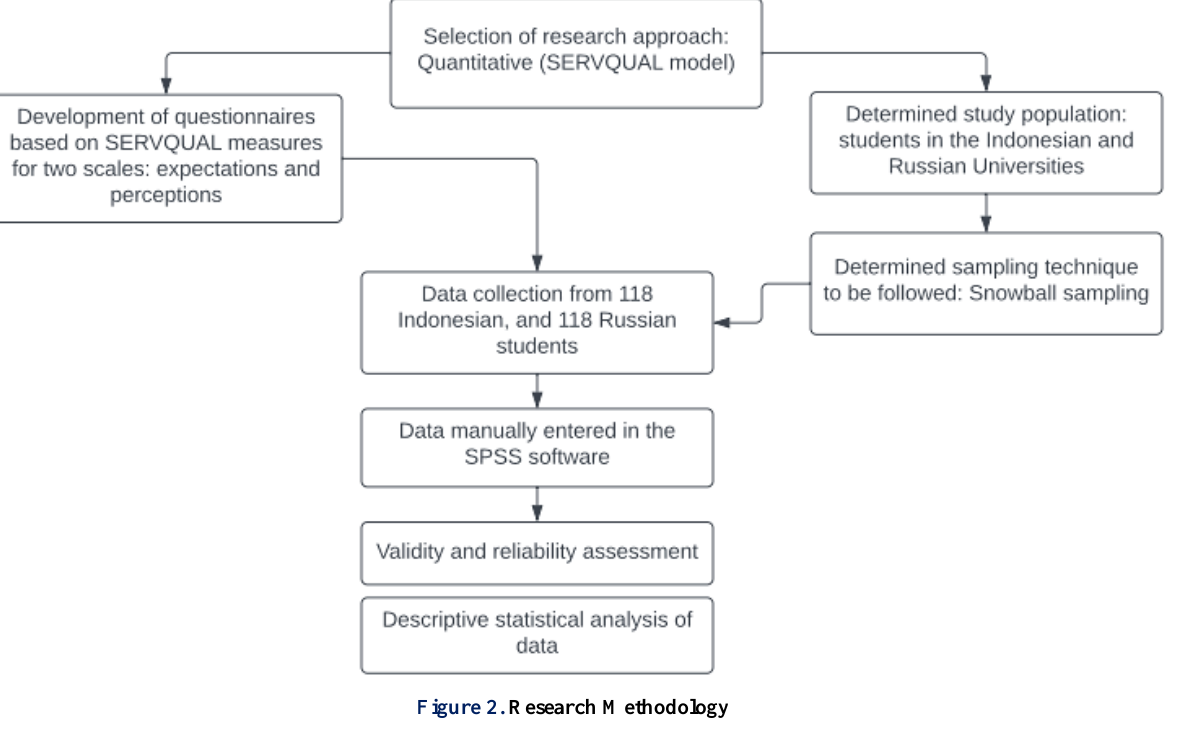
Figure 2. Research